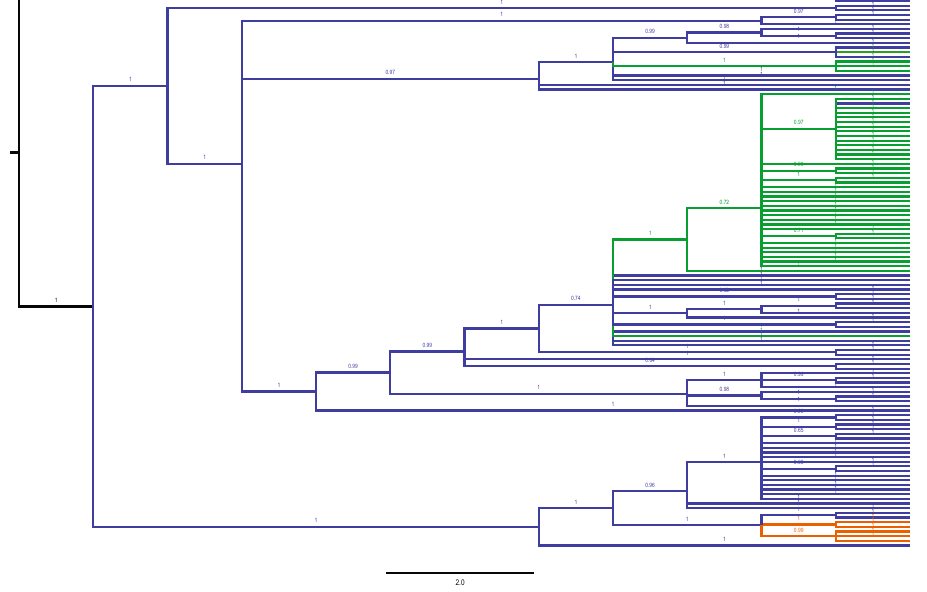
Figure 4. MrBayes reconstruction based on all the concatenated mitochondrial markers of 3 taxa of Oenanthe and its outgroup. 38 breeding samples and 79 migrant samples (caught in Helgoland and Crete) were included. Numbers above nodes refer to the support values of Bayesian posterior probability. Taxa identifications are color coded based on the field data: outgroup (black), O. o. oenanthe (blue), O. o. leucorhoa (green) and O. seebohmi (orange).